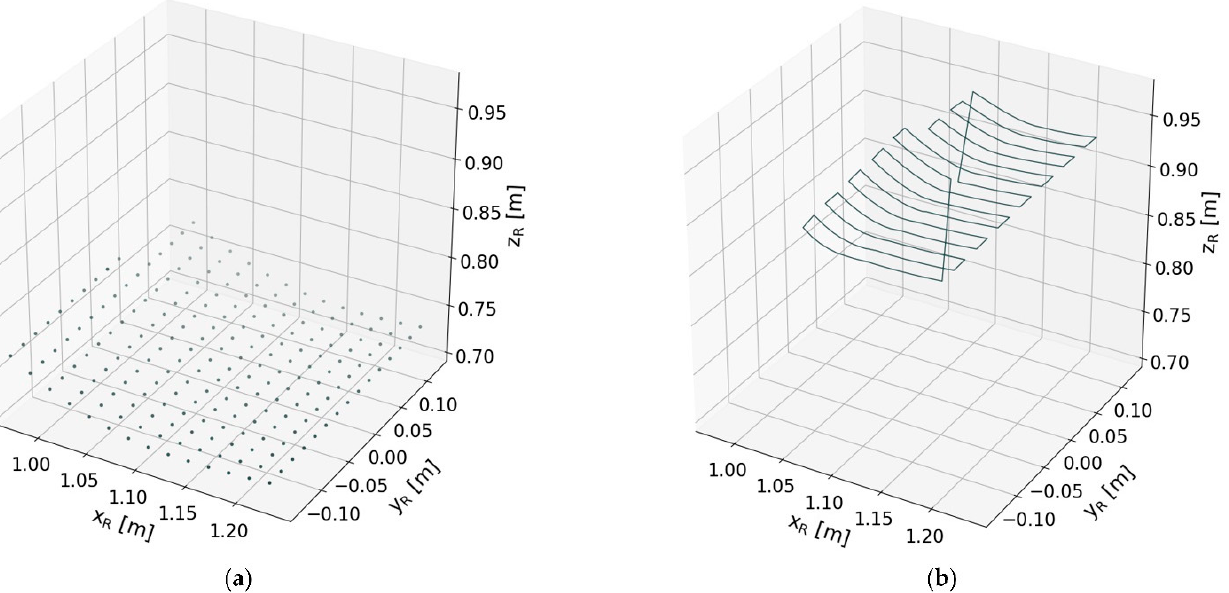
Figure 18. Execution of inspection process at one local subsegment of the work piece. ( a ) 3D positions of the end-effector shifted alongside the surface normal by the amount of the scanning distance; ( b ) path executed by the end-effector during the inspection process.